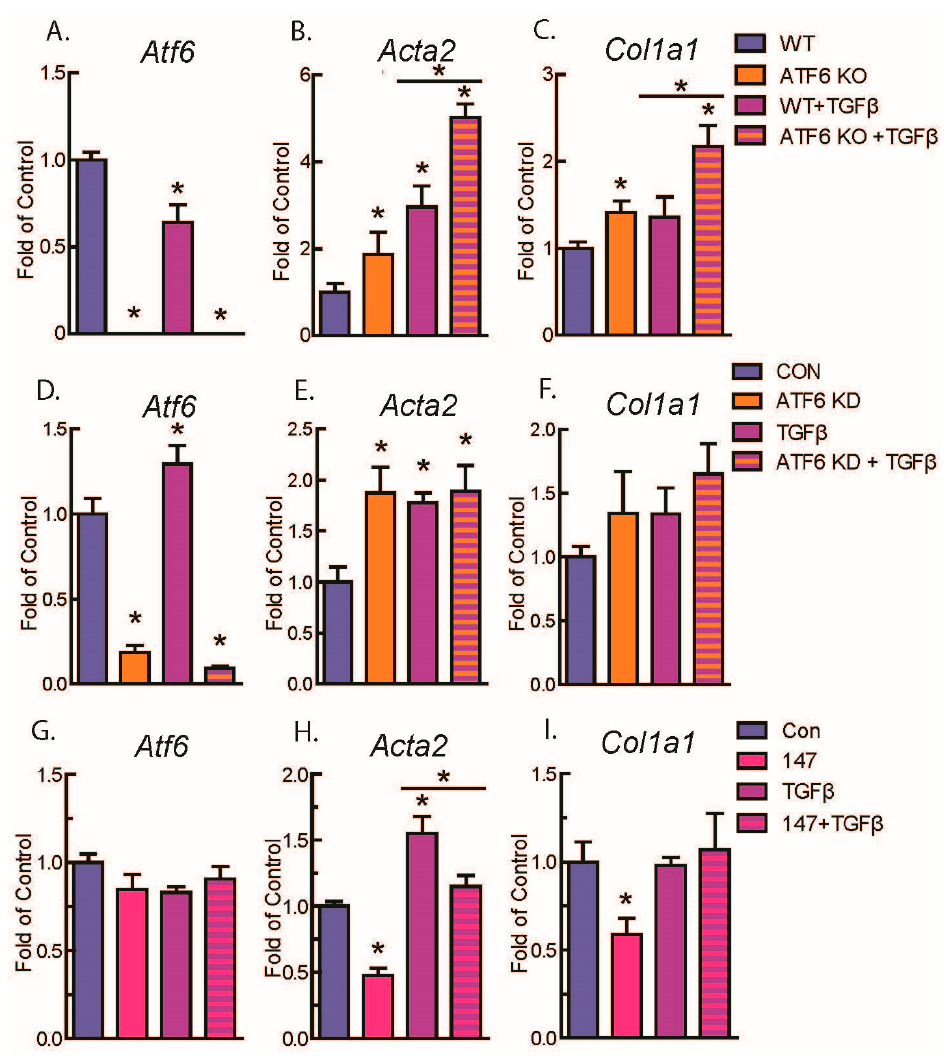
Figure 2. qRT-PCR of adult murine ventricular fibroblasts (AMVFs) with ATF6 gain- or loss-of-function. ( A–C ) WT and ATF6 KO AMVFs were treated with ±10 ng/mL transforming growth factor β (TGF β) for 48 h, then analyzed by qRT-PCR for Atf6 , Acta2 , and Col1a1 . ( D–F ) AMVFs